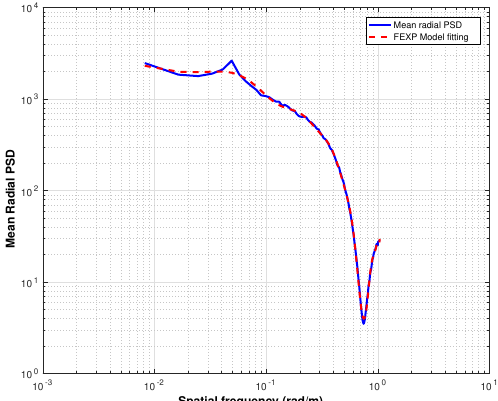
Figure 2. Fitting of the FEXP model with the mean radial PSD of a clean sea